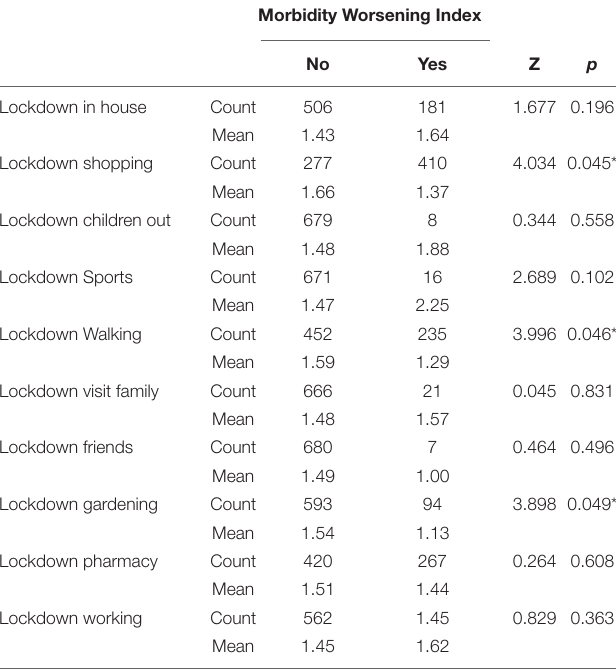
TABLE 9 | Lockdown characteristics and the Morbidity Worsening